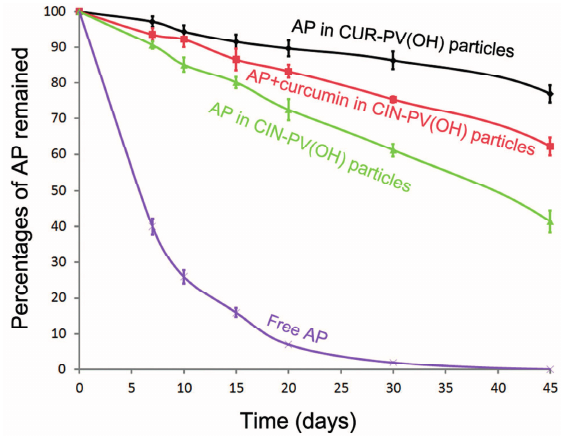
Figure 3. Stability of dry free AP (unencapsulated AP), or AP encapsulated in